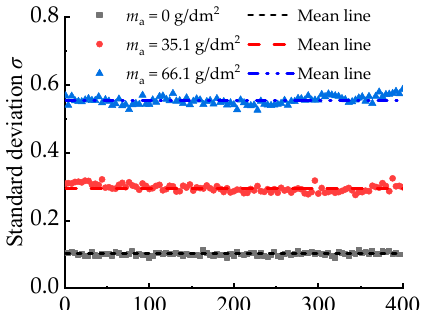
Figure 7. Standard deviation of surface height of two-dimensional contour curves.